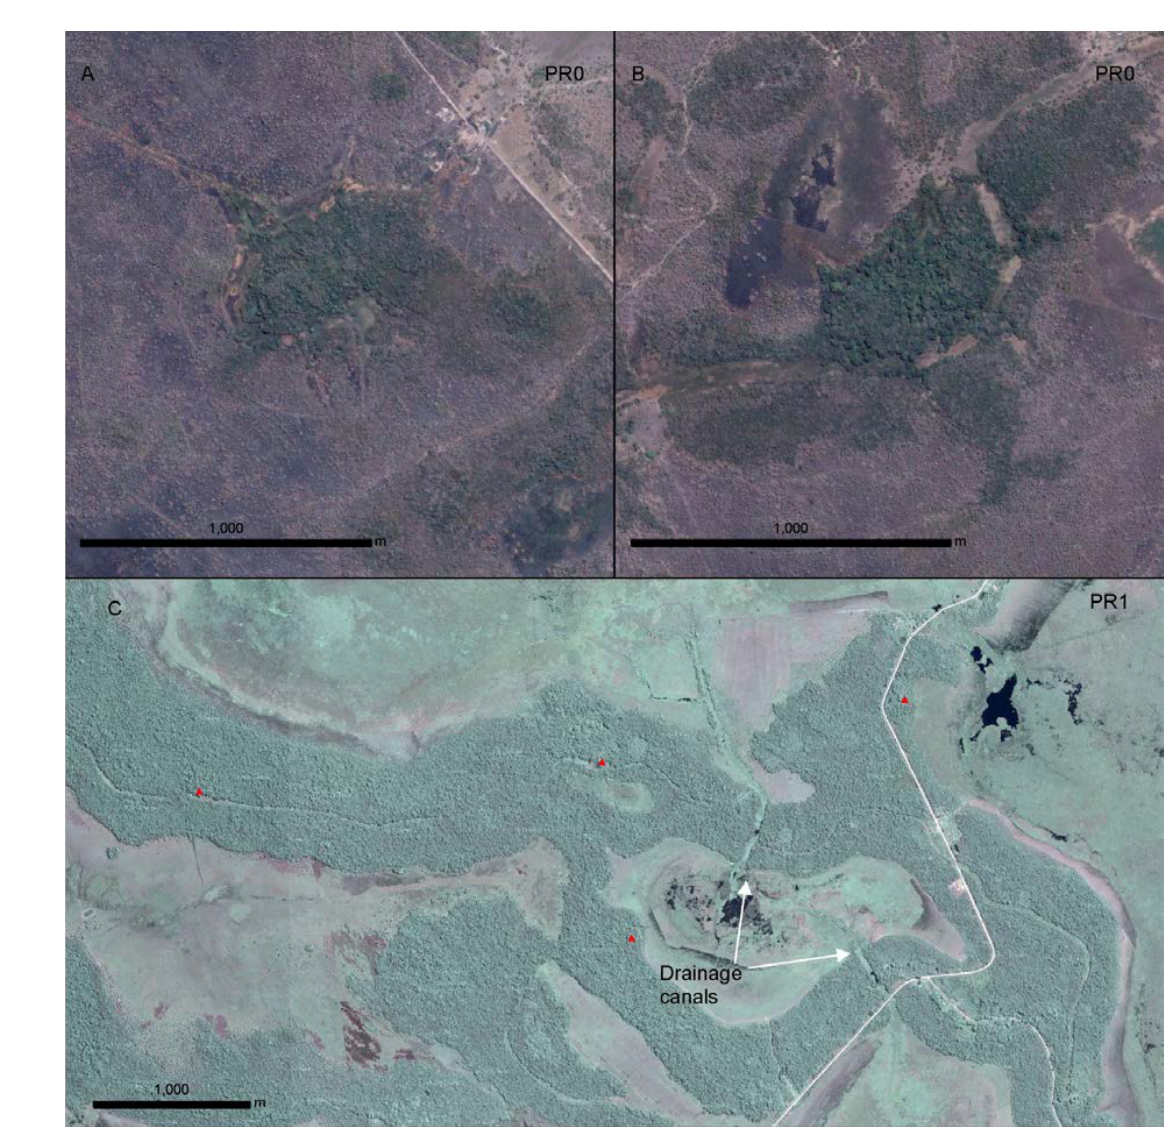
Figure 3. Vegetation over the mounds vs. vegetation over levees. In PR0, (a) and (b) , densely forested mounds are easily discernible from their surroundings covered by savannah or sparse forest; while in PR1, (c) , the forest growing on the mounds (red triangles) is hardly differentiable from the forest growing on the rest of the levees.